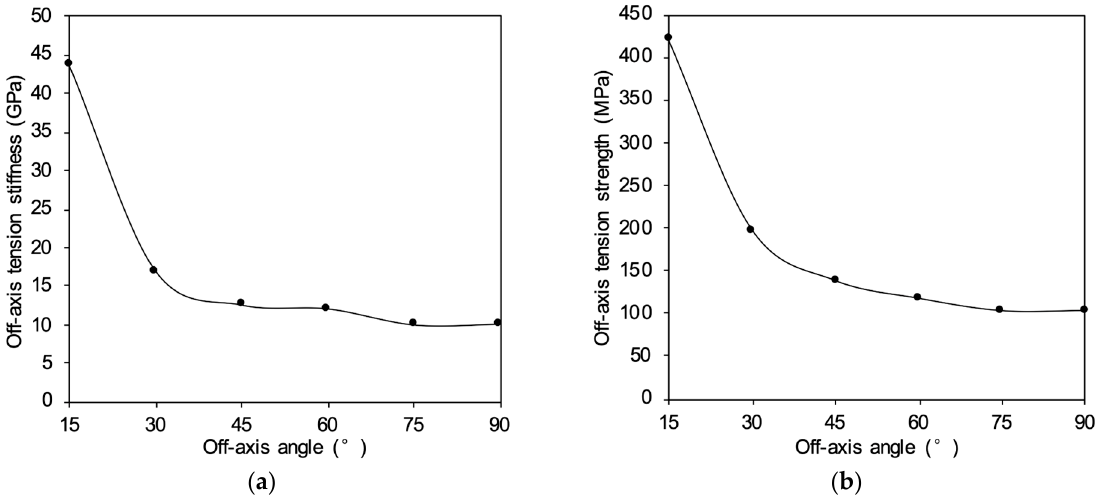
sharply from 419.6 MPa to 137.4 MPa with the angle increased from 15° to 45°. The strength then slowly descends to 102.1 MPa as the off-axis angle rises to 90°.